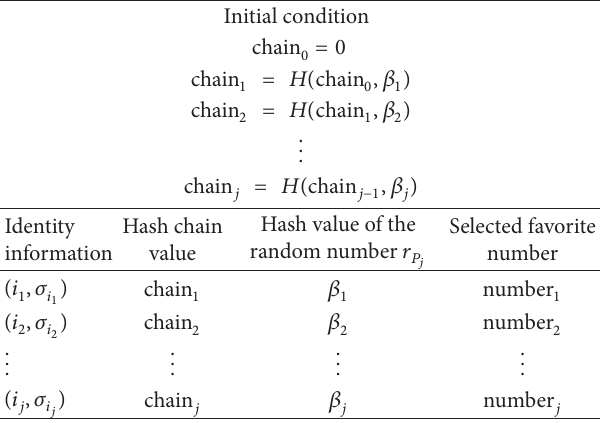
Table 1: The information of bulletin